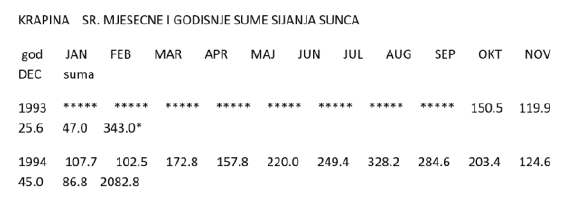
Figure 8. Data from DHMZ for the area of Krapina The approximate quantity of electric power that can be obtained by using solar panels at the most convenient surfaces (Photovoltaic-software 2017) has been calculated on the basis of DHMZ data and of average efficiency of solar panels